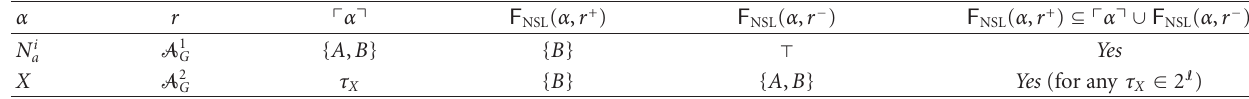
Table 8: Analysis of NSL: role of A .